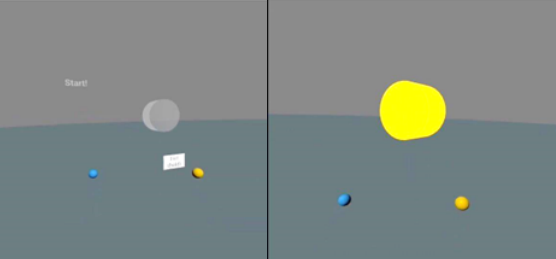
Figure 2. User view of the test — simple reaction in VR (gray — waiting for the stimulus, yellow — right hand reaction).